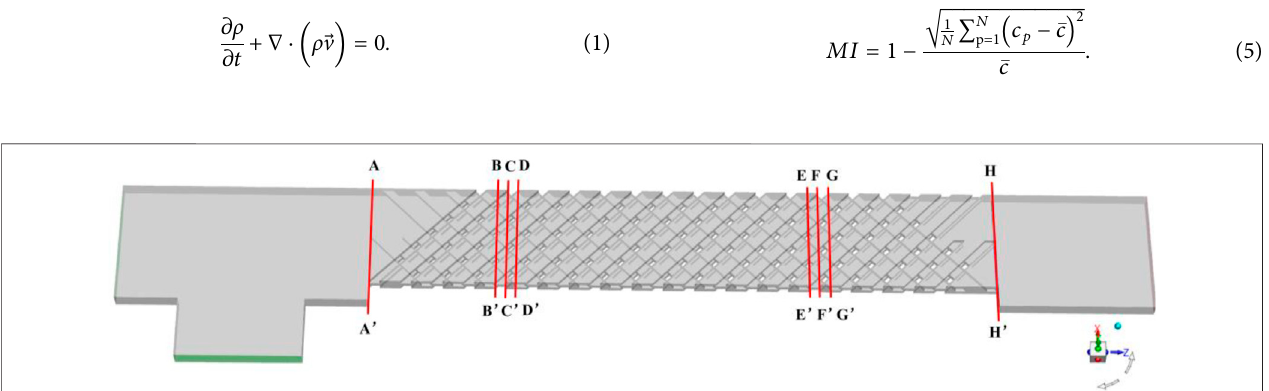
FIGURE 6 | Positions of selected x-y